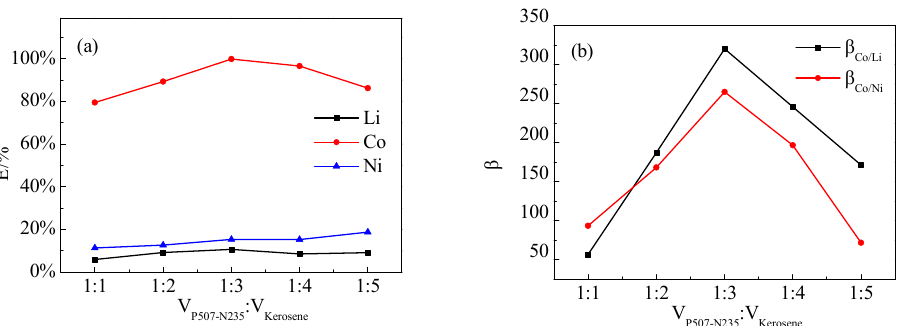
Figure 8. Effect of V P507-N235 :V kerosene ratio on: ( a ) extraction efficiency and ( b ) separation coefficient (V P507 :V N235 = 3:7, V o :V a = 3:1, pH = 4.0).